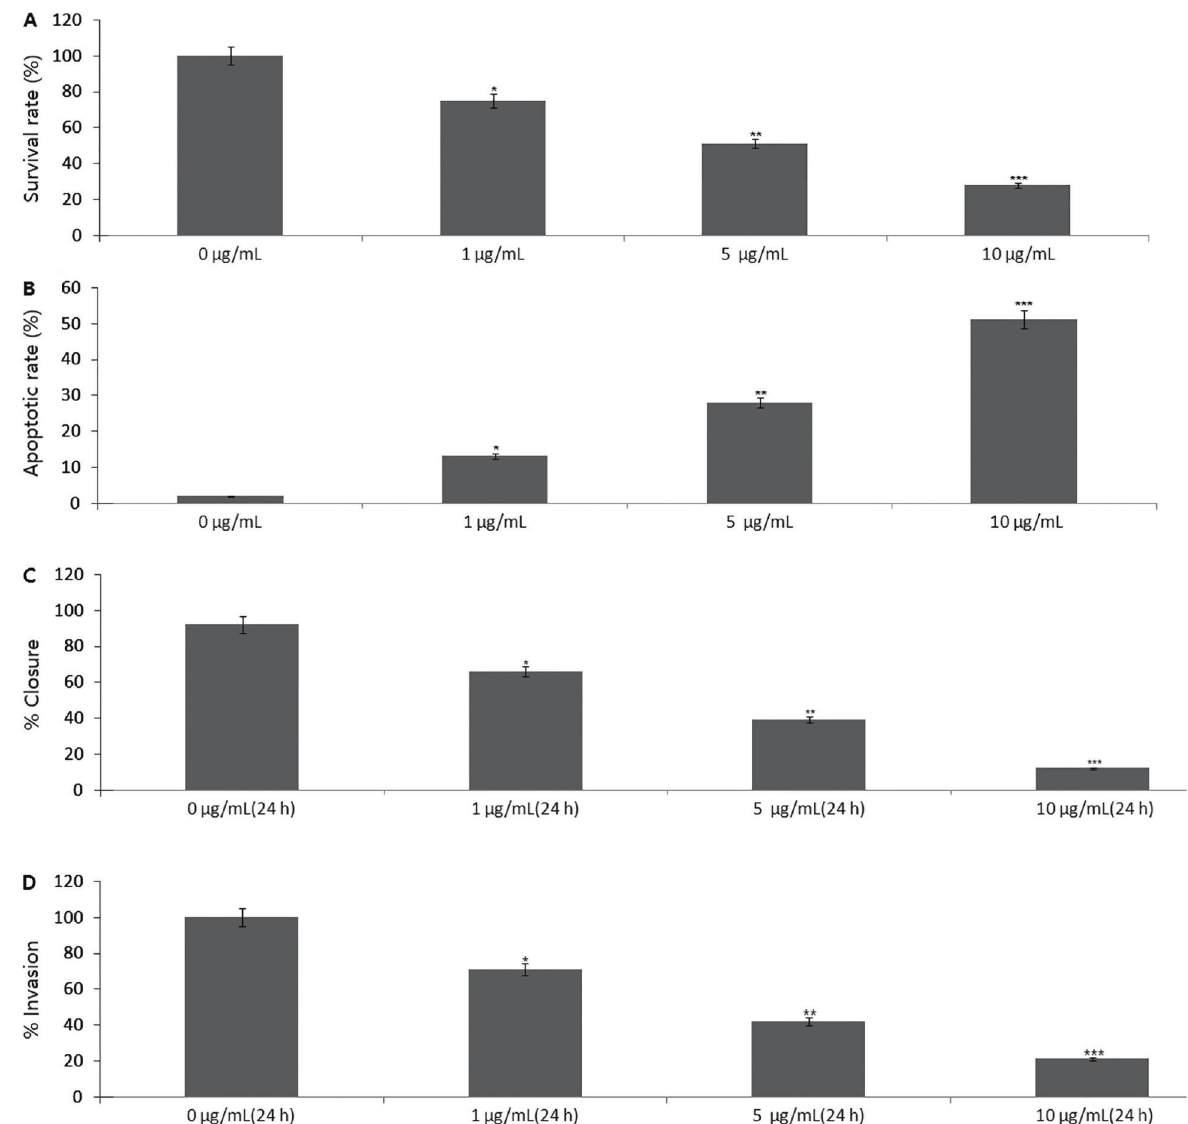
Figure 1. Results of ES-2 cells treated with 1, 5, and 10 m g/mL propofol for 24 h. A , Cell viability by MTTassay. B , Cell apoptosis using Annexin V-staining followed by a FACScan fl ow cytometer assay. C , Migration by wound healing migration assay. D , Transwell invasion assay vs untreated cells (0 m g/mL). *P o 0.05, **P o 0.01, ***P o 0.001 ( t (Figure 2D) were signi fi cantly increased. In the pre- experiment, we had found that scrambled miR-9 inhibitor (negative control) did not affect p65, MMP-9 and NF- k B levels, so we did not show the effect of scrambled miR-9 inhibitor in the present study.